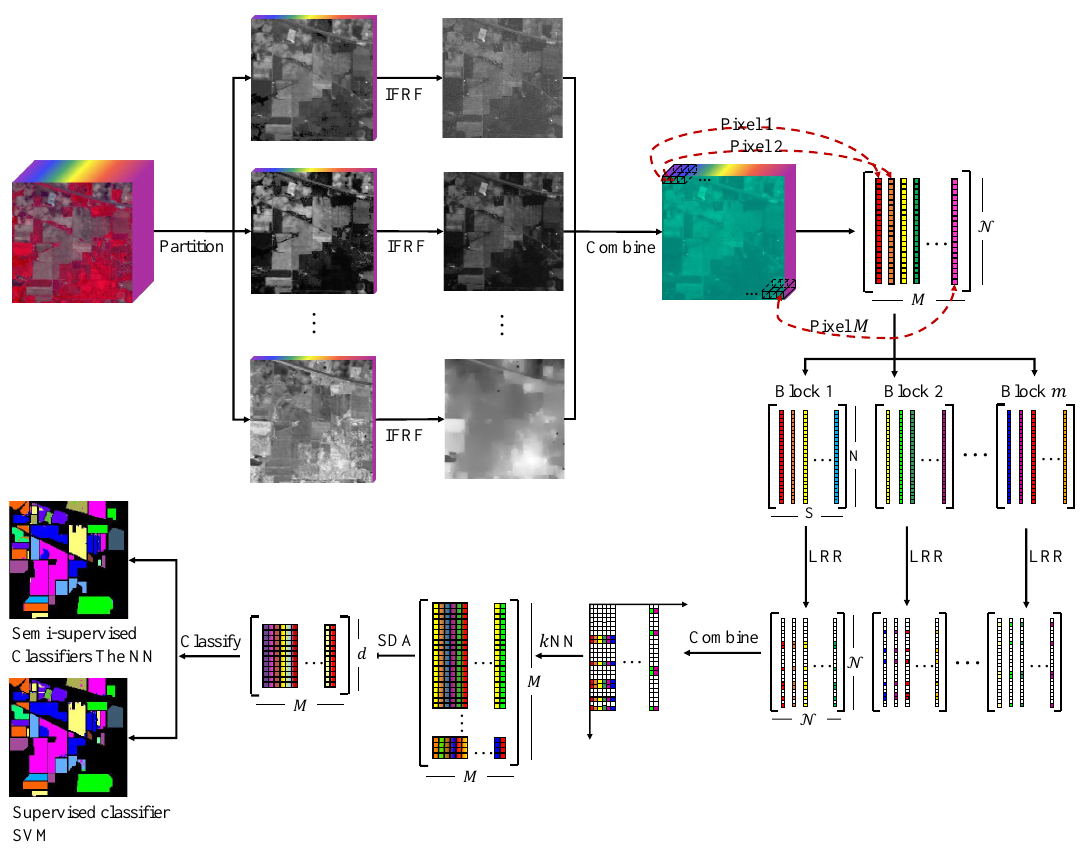
Figure 1. Formulation of the proposed regularized block low-rank discriminant analysis feature extraction for Hyperspectral Image (HSI) classification. IFRF, Image Fusion and Recursive Filtering; SDA, Semi-supervised Discriminant